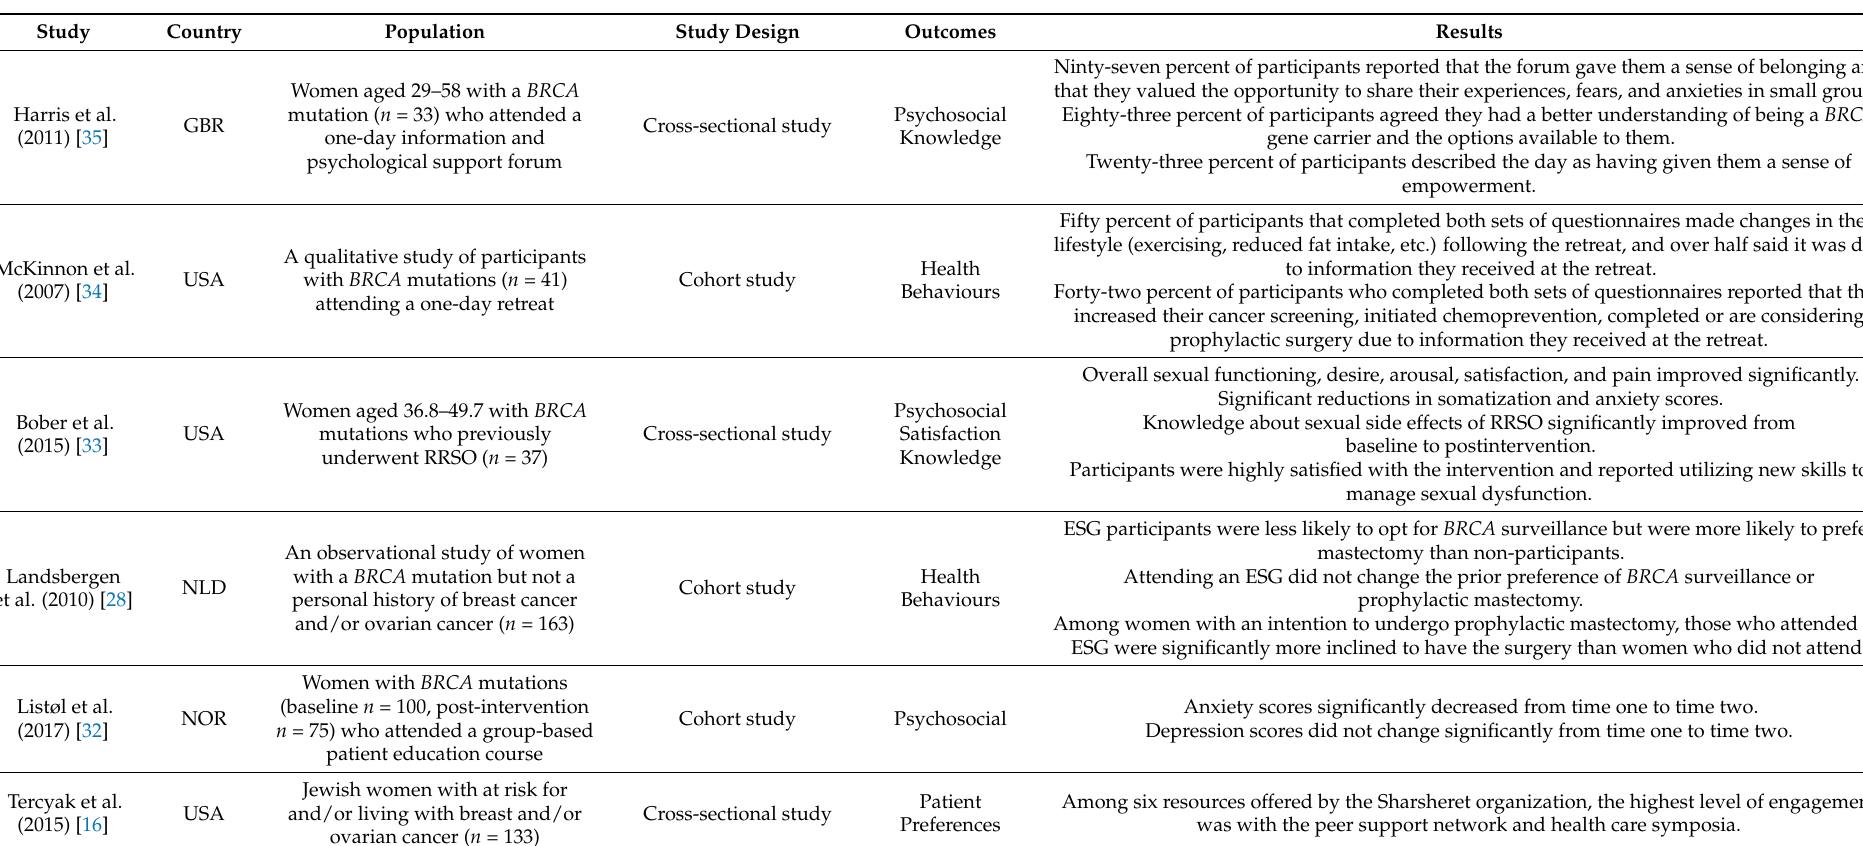
Table 4. One-Day